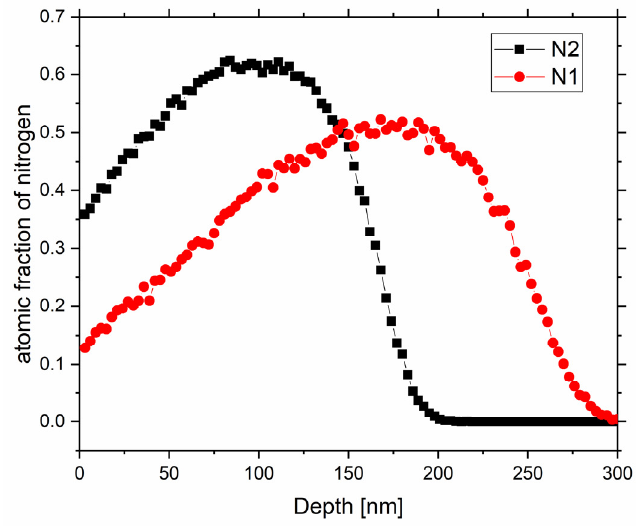
Figure 2. Simulated nitrogen concentration vs. depth for the two implantation processes. N1 refers to N + implantation and N2 refers to N 2 + implantation.